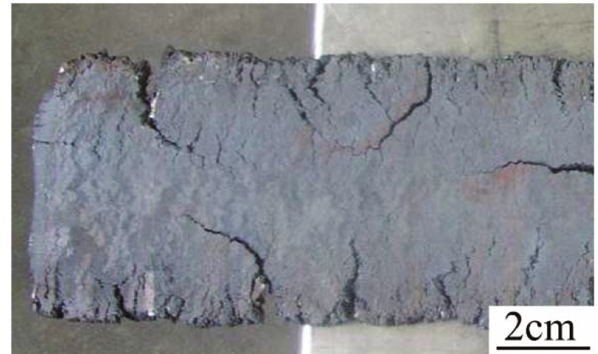
Figure 4: The cracked ingot during hot forged process.